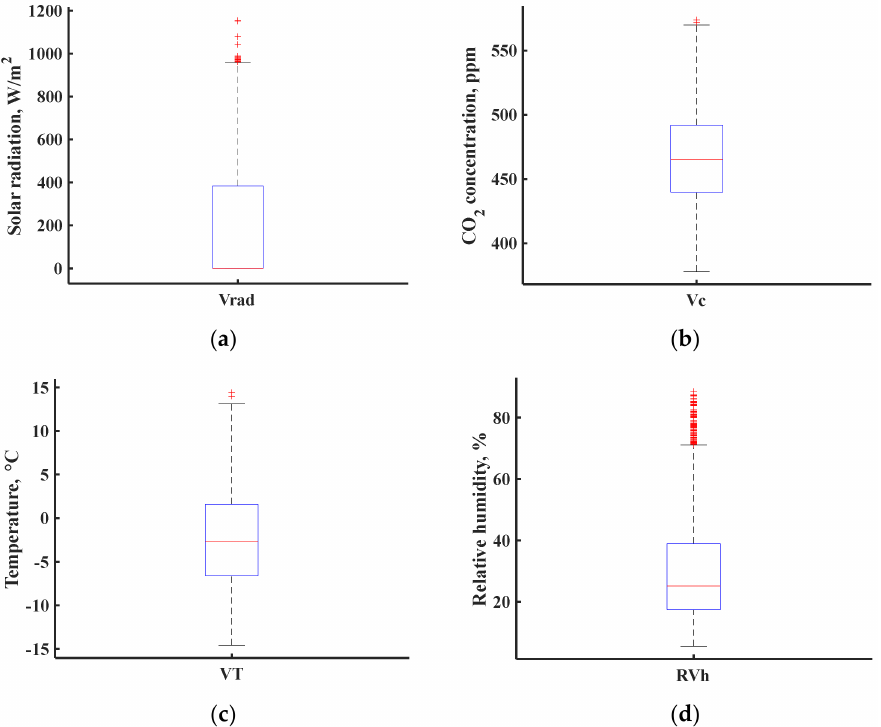
Figure 3. External weather in Lhasa. ( a ) External solar radiation, ( b ) External CO 2 concentration, ( c ) External temperature, ( d ) External relative humidity.